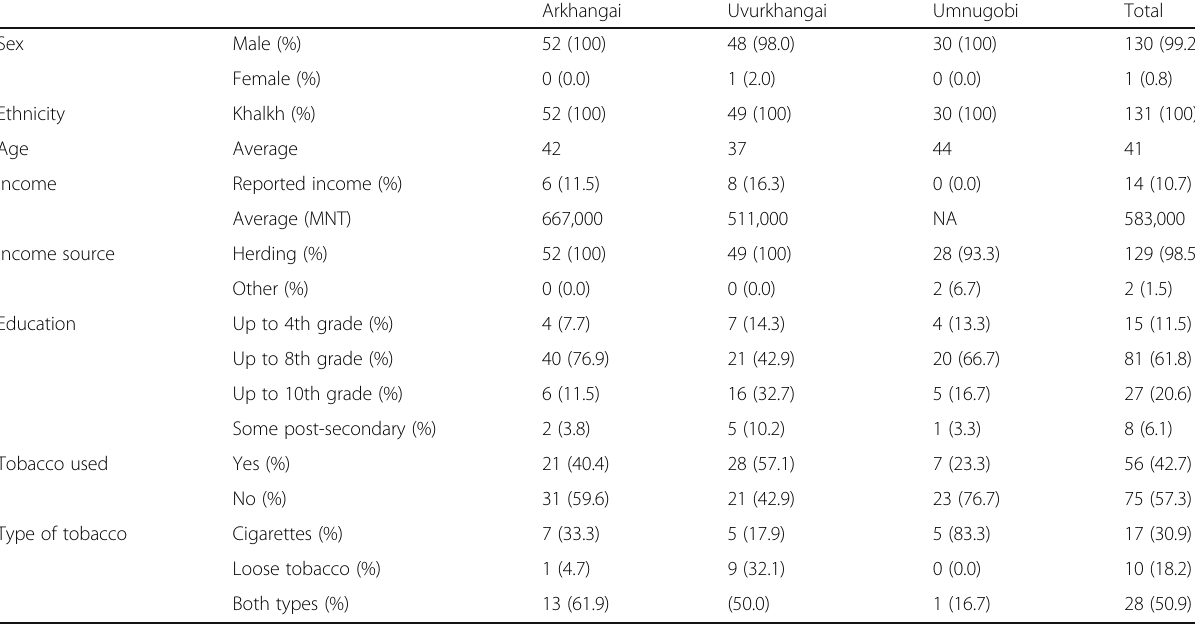
Table 1 Descriptive statistics for the participating survey head of households ( n = 131)